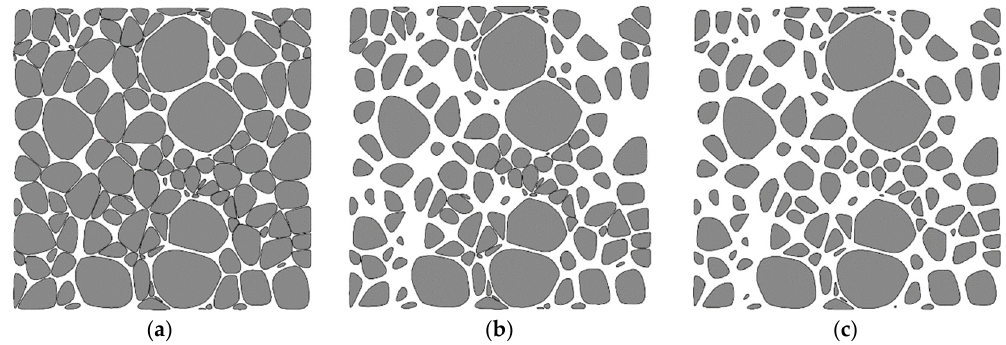
Figure 4. Aggregate distribution development at a slice during the scaling procedures. ( a ) After scaling of the 80–150 mm group, ( b ) after scaling of the 40–80 mm group, and ( c ) after scaling of the 20–40 mm group.